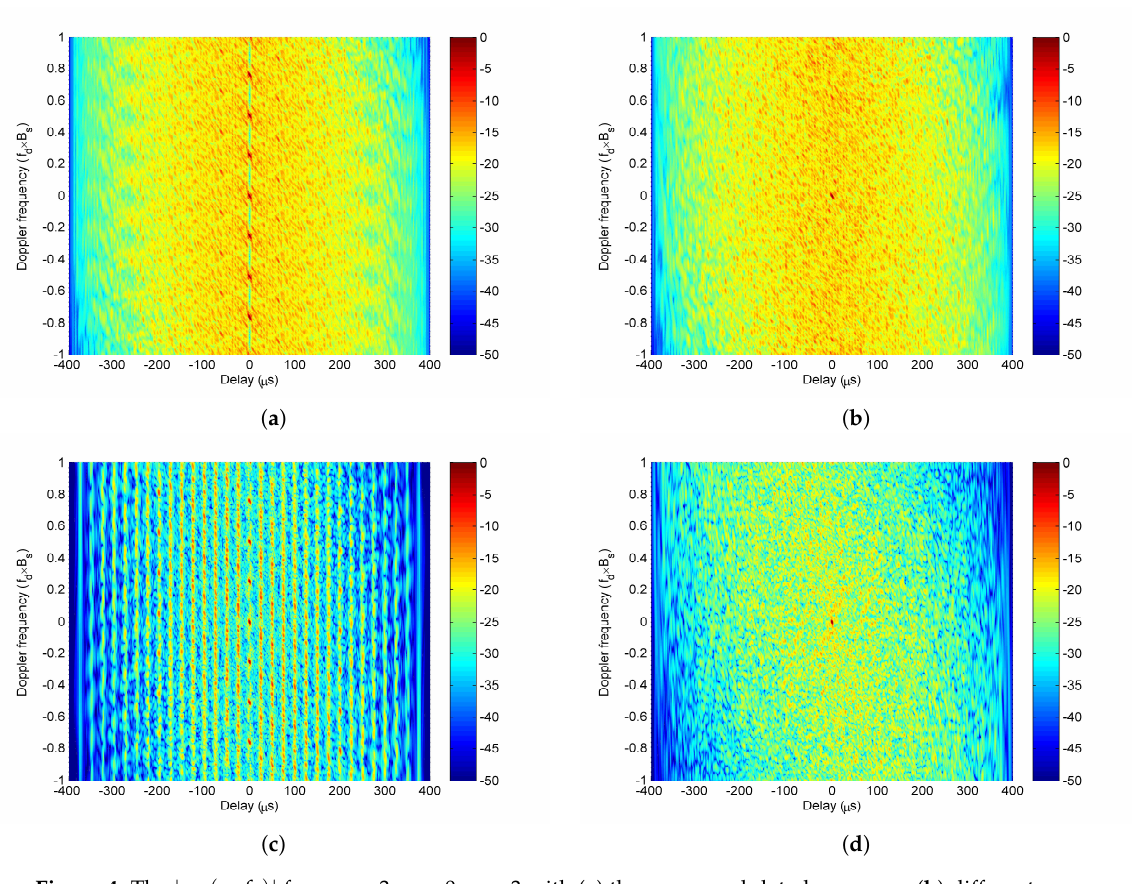
Figure 4. The | χ v ( τ , f d ) | for v = − 3, · · · ,0, · · · ,3 with ( a ) the same modulated sequence; ( b ) different modulated sequences. The ambiguity functions of the LFM-PC waveform set with ( c ) the same modulated sequence; ( d ) different modulated